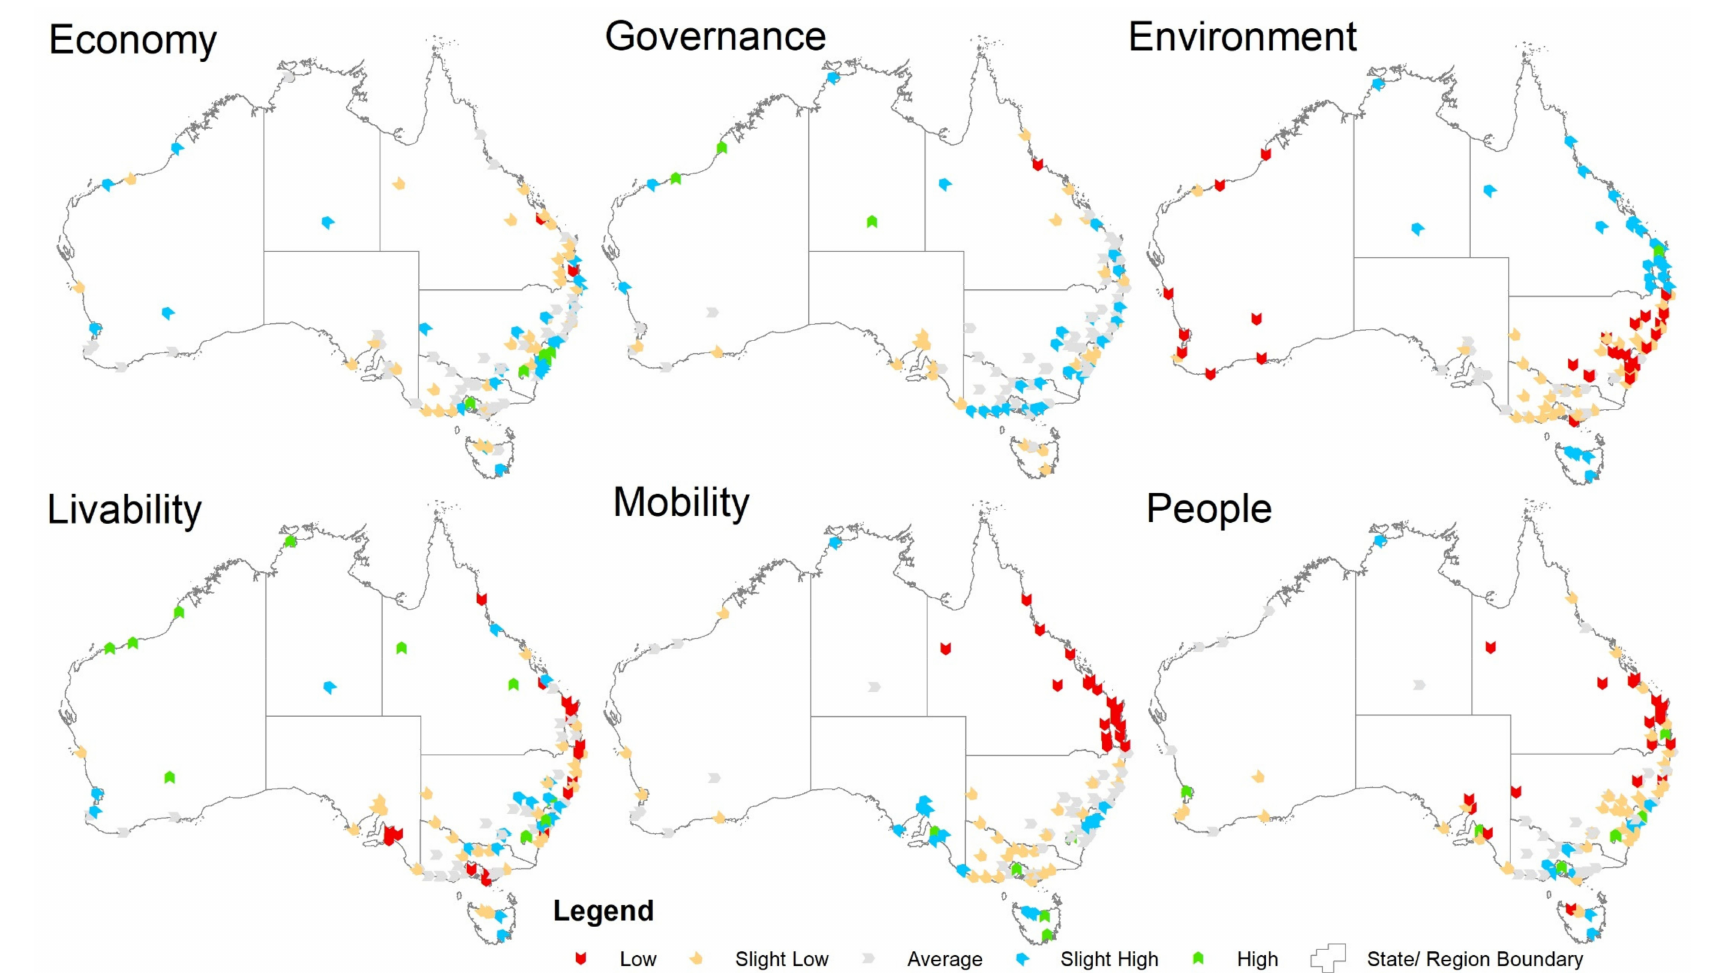
Figure 8. Preferred cities’ performance at the component